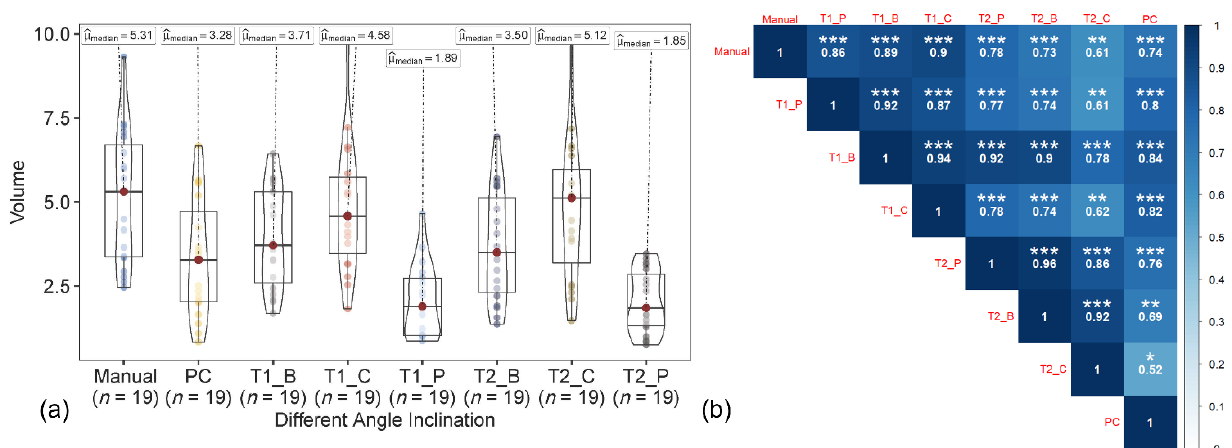
Figure 10. ( a ) Violin box plot showing the canopy crown volume range (m) and the ( b ) correlation matrix showing correlation between ground reference data and estimated volume with a 45° sensor angle dataset using T1, T2, and point cloud (PC) UAV-based approaches with canopy area estimated using polygon, box, and circular canopy area. Significant probability level: * 0.05, ** 0.01, and *** 0.001.